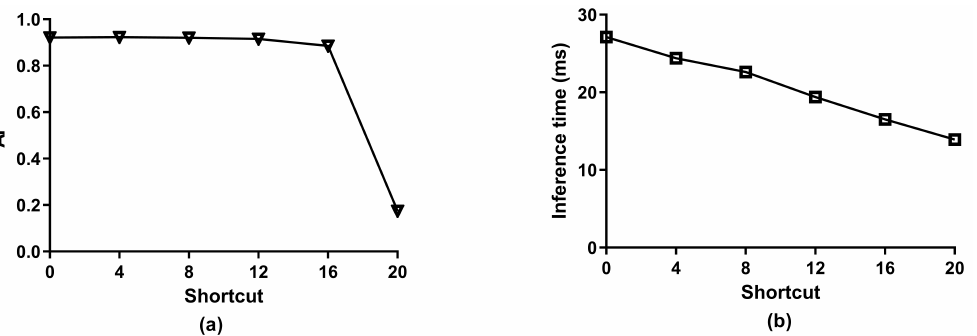
Figure 7. Influence of the number of the pruned residual structure: ( a ) AP curve and ( b ) inference